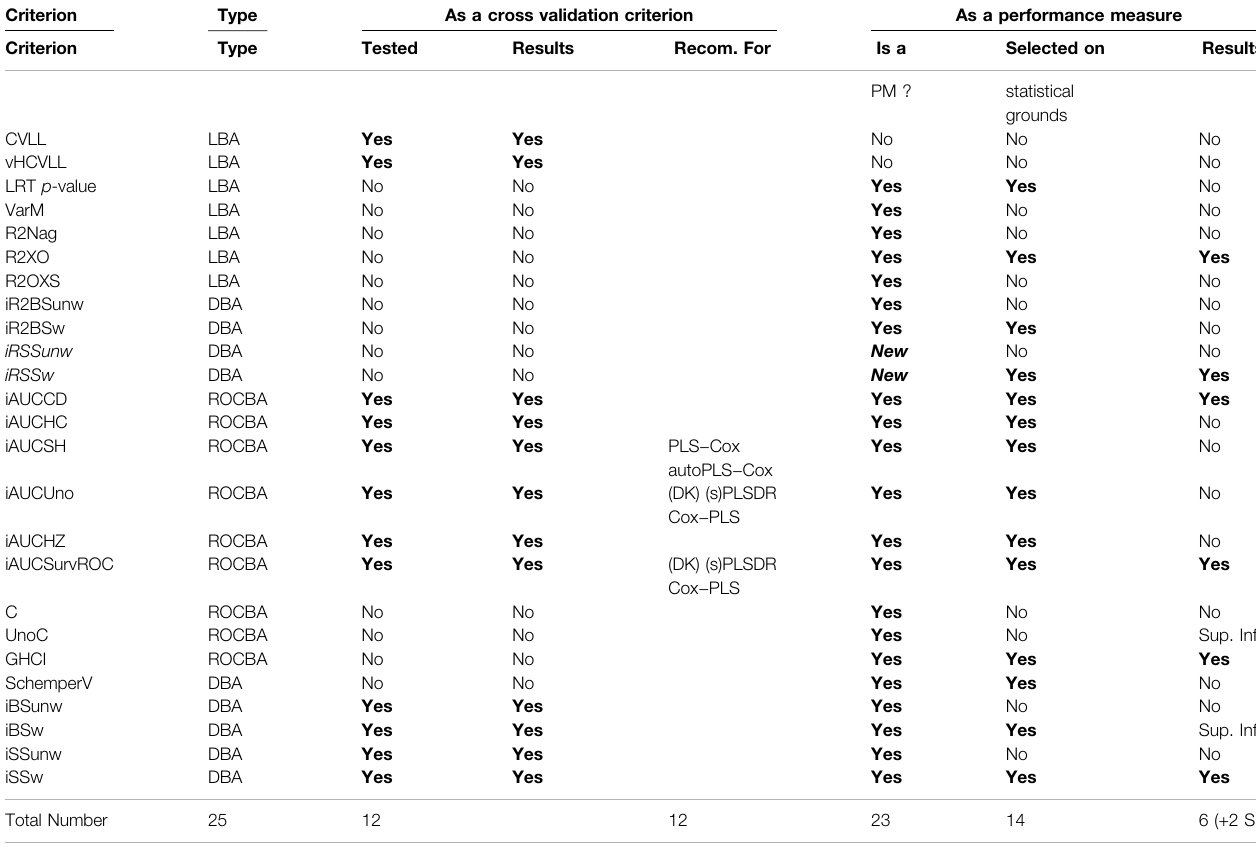
TABLE 1 | Criteria and their use in the cross validation step or as a performance measures for assessing the quality of the